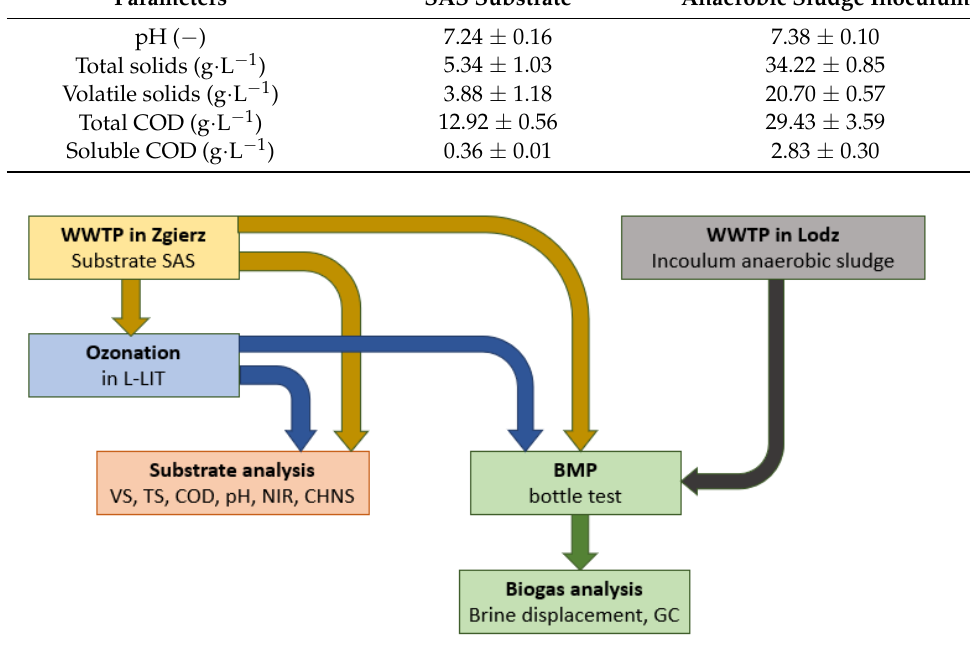
Figure 6. The scheme of the